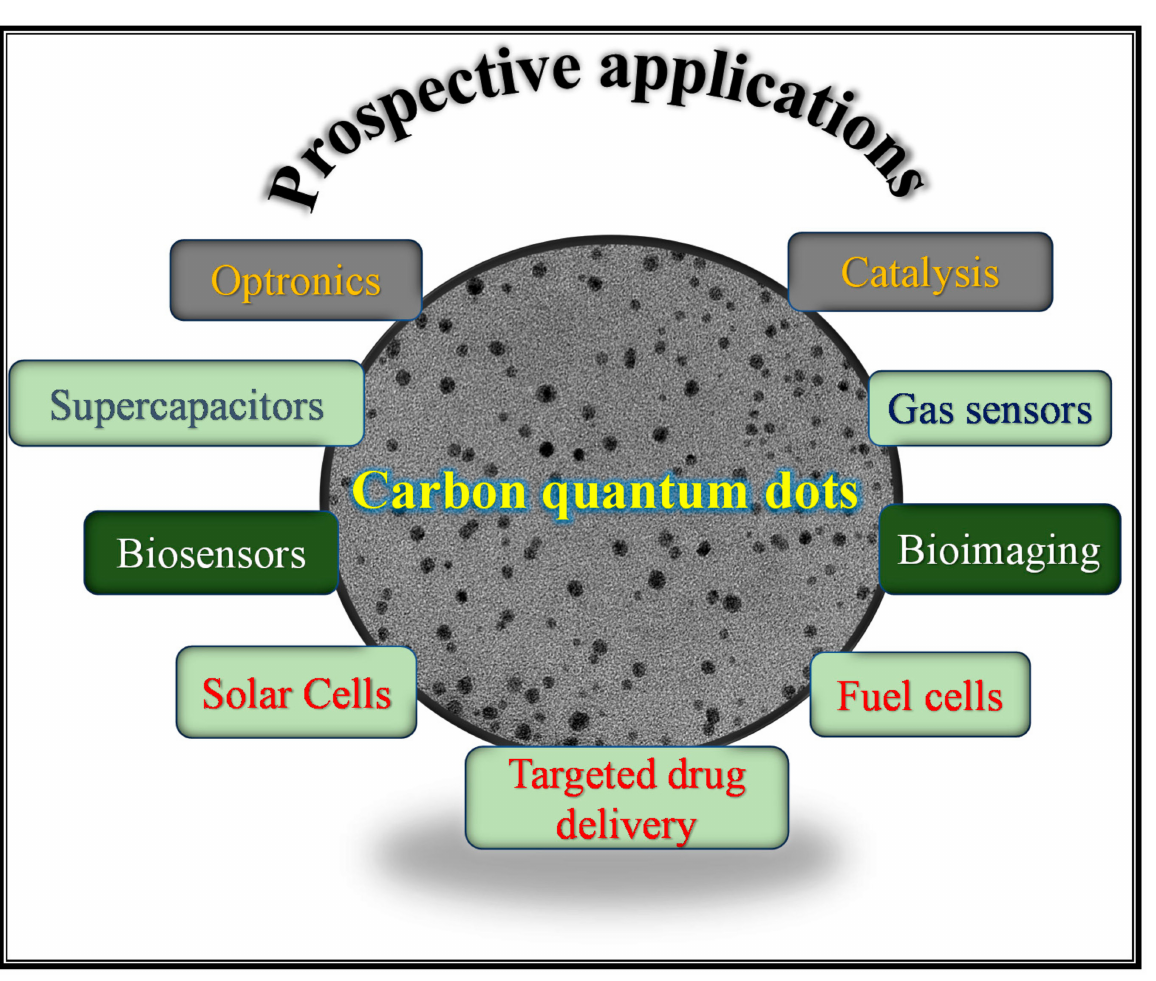
Figure 10. Prospective application for carbon quantum dots.